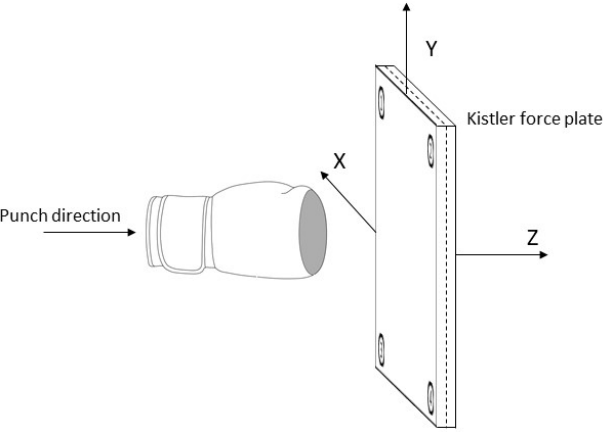
Figure 2 . Test setup schematic [19]. Figure 2. Test setup schematic